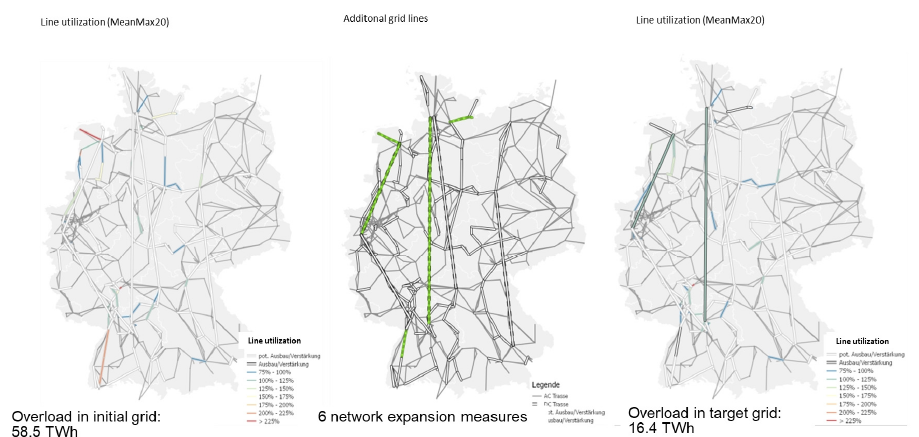
Figure 6. Results of iterative grid expansion for decentralized distribution scenario.